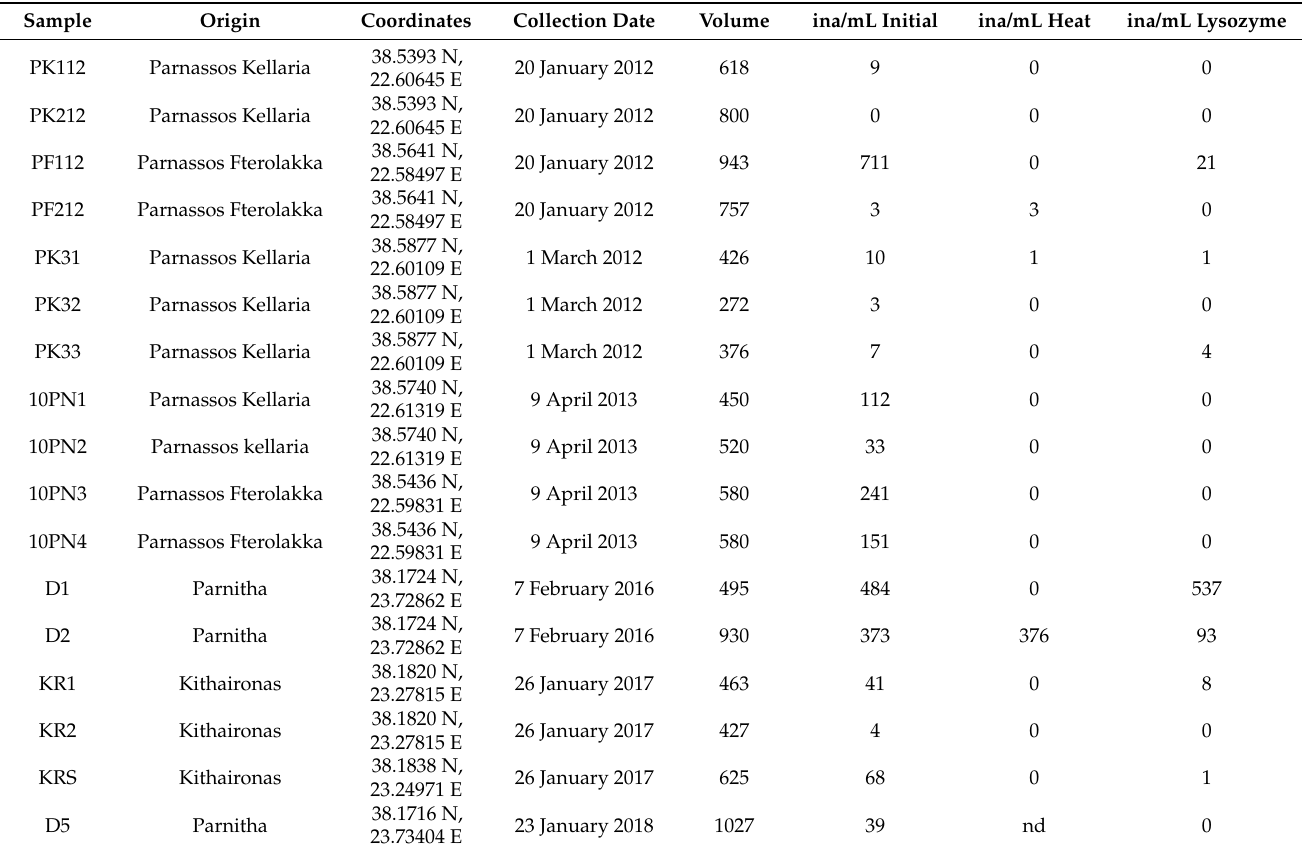
Table 1. Snow samples showing information about their origin and their ice nucleation activity prior to and after treatment with heat (100 ◦ C for 15 min) and lysozyme (nd = not done). Numbers have been rounded to the nearest integer. Dates are shown as day/month/year.